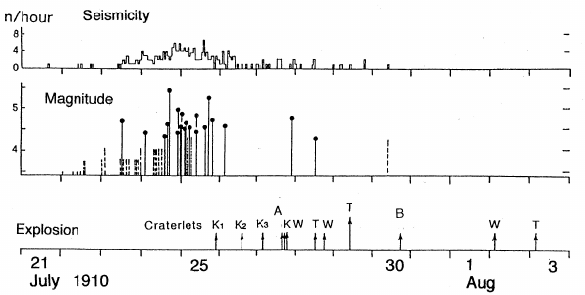
Fig. 7. Temporal sequences of the 1910 eruption of the Usu volcano (after Yokoyama and Seino, 2000). Seismicity: hourly numbers of earthquakes (M ≥ 3.0) observed at Sapporo. Explosion: strength in arbitrary scale. Craterlets K: Kompira